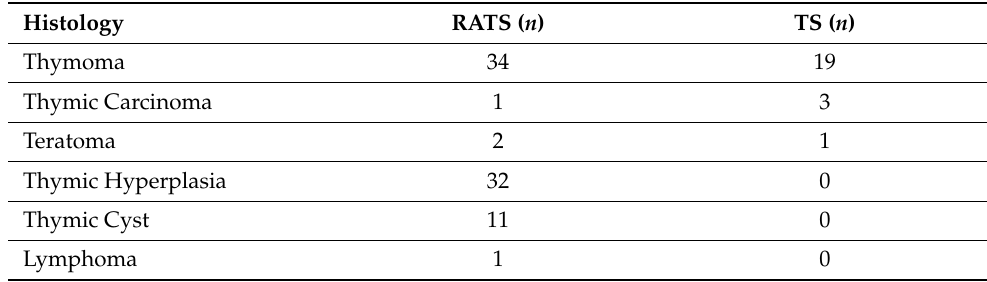
Table 3. Histopathological results.